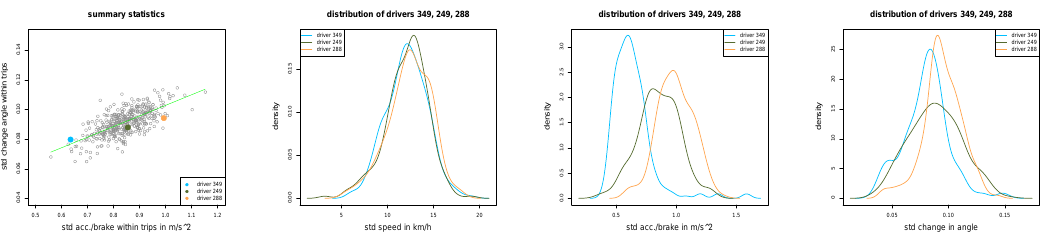
Figure 12. ( left ) Scatter plot ( σ a , σ ∆ ) of all n = 416 drivers with drivers 349, 249 and 288 in light blue, dark green and orange colors; ( middle and right ) density plots of σ v , s , σ a , s and σ ∆ , s for s = 1, . . . , S of the three drivers 349, 249 and 288.